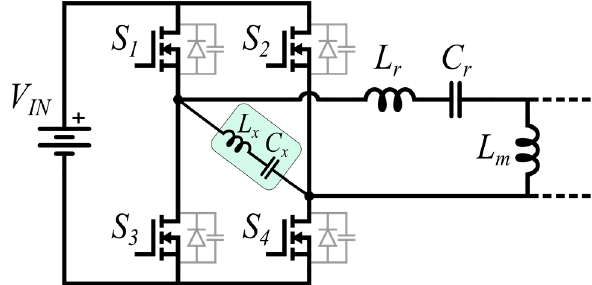
Figure 16. Proposed auxiliary circuit.